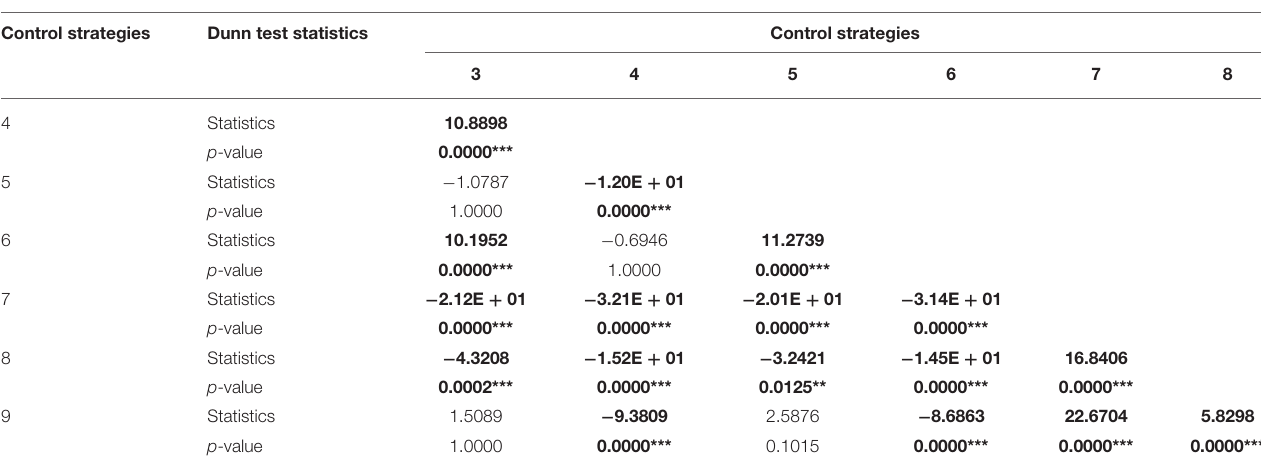
TABLE 9 | Dunn test of total animals vaccinated for Scenario VIC3. Control